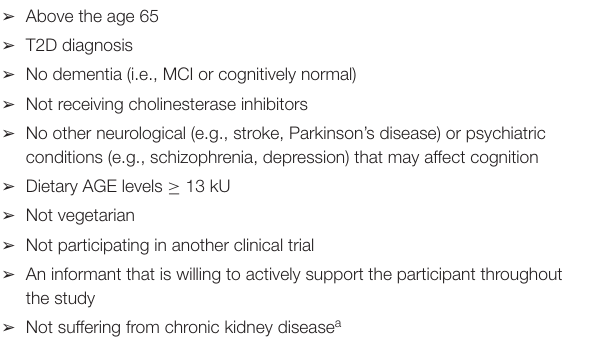
TABLE 1 | Eligibility